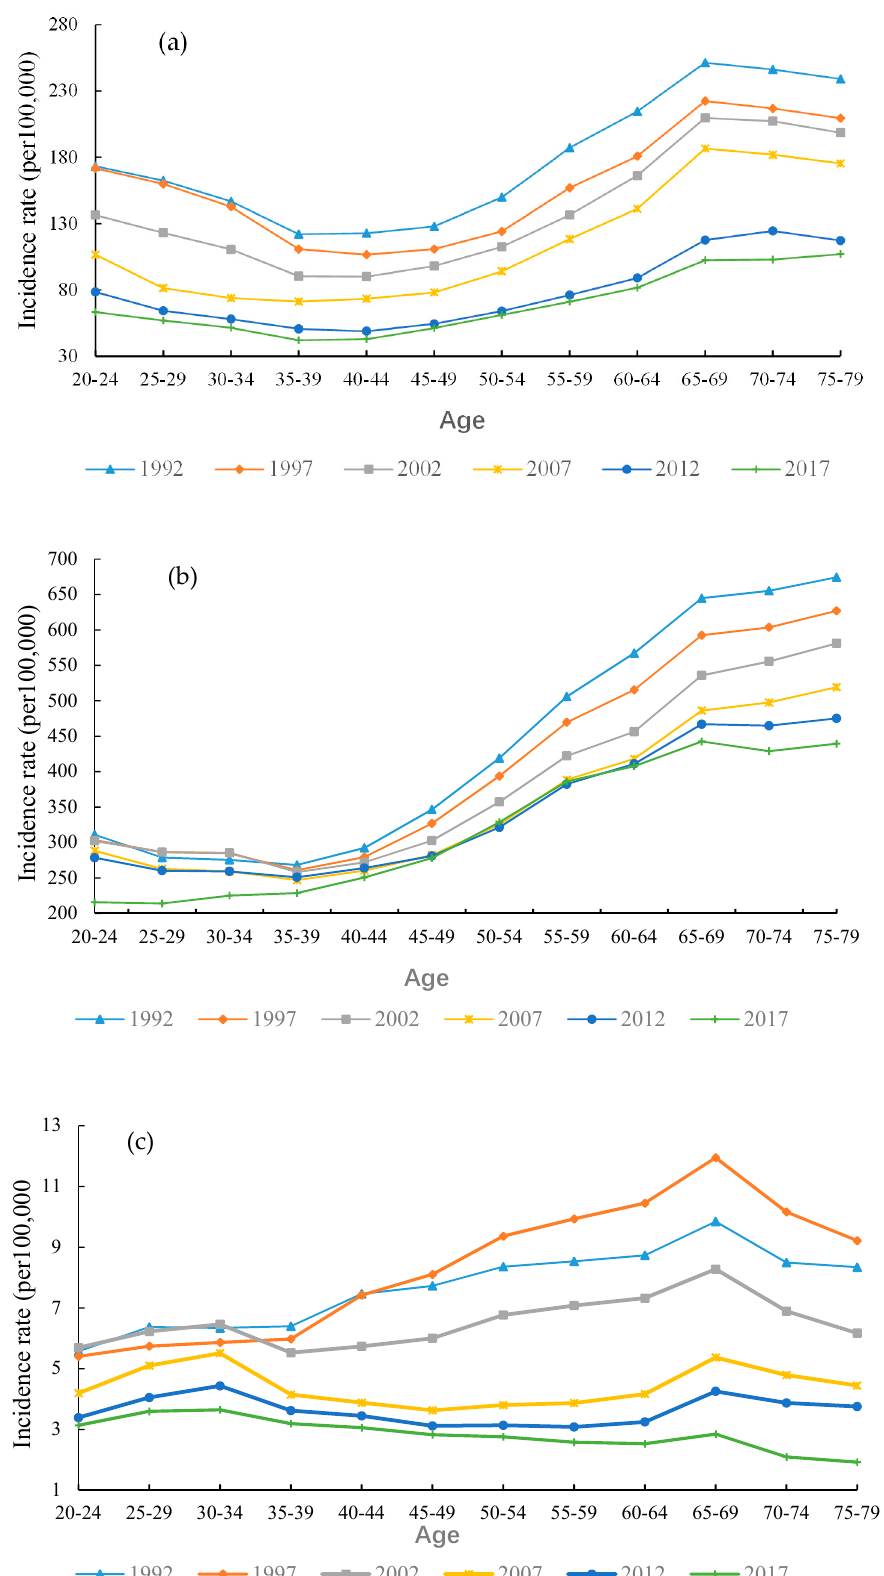
Figure 4. Age-specific TB incidence rate for ( a ) China, ( b ) India, ( c ) United States, 1992 to 2017.